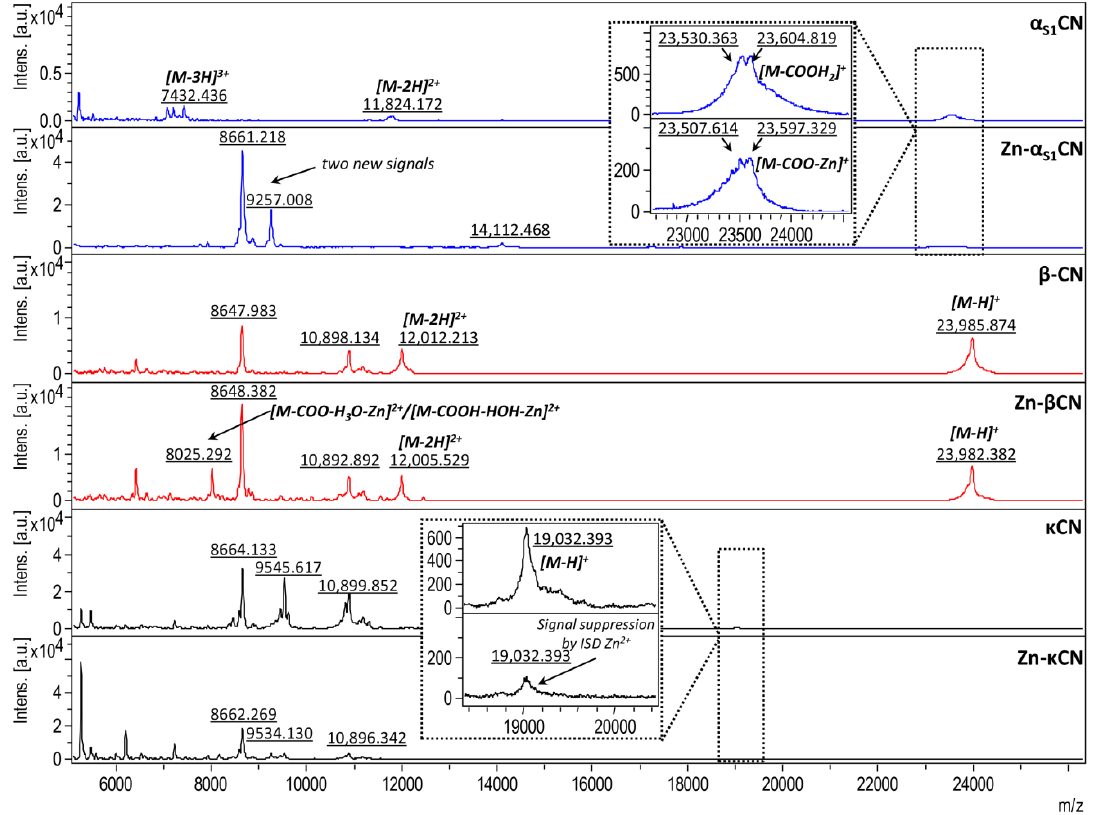
Figure 6. Mass spectra of intact standard solutions of α S1 CN, βCN, κCN and their complexes with zinc ions (Zn-α S1 CN, Zn-βCN, Zn-κCN).